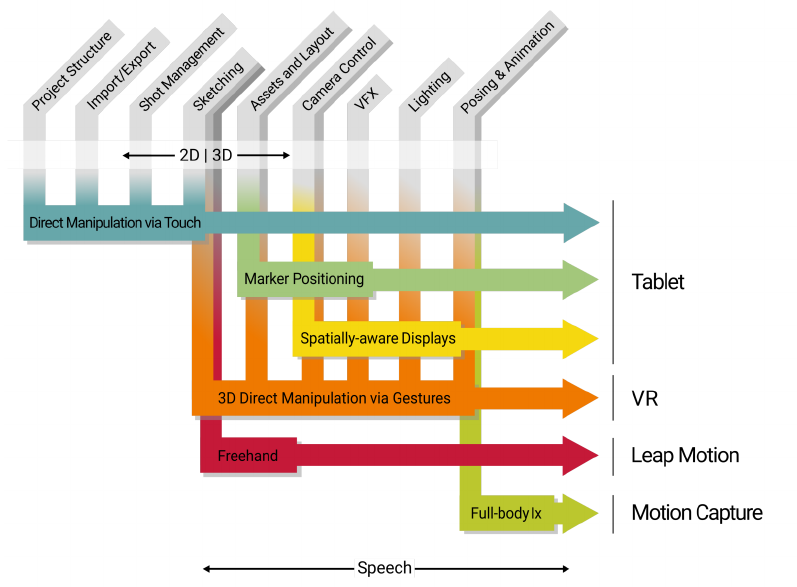
Figure 1. From previs tasks over interaction techniques to